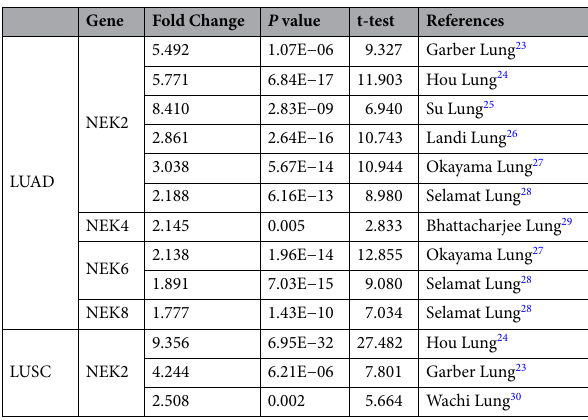
Gene Fold Change P value